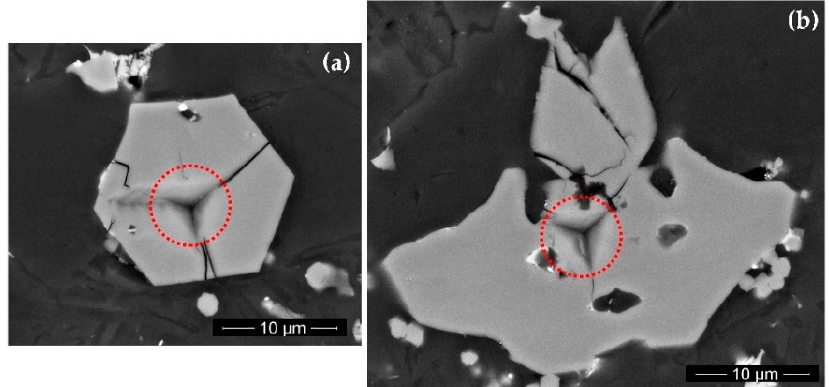
Figure8. SEM imagesof nanoindentation impressions in ( a ) polyhedraland ( b ) star-like sludge particles. Figure 8. SEM images of nanoindentation impressions in ( a ) polyhedral and ( b ) star-like sludge particles.